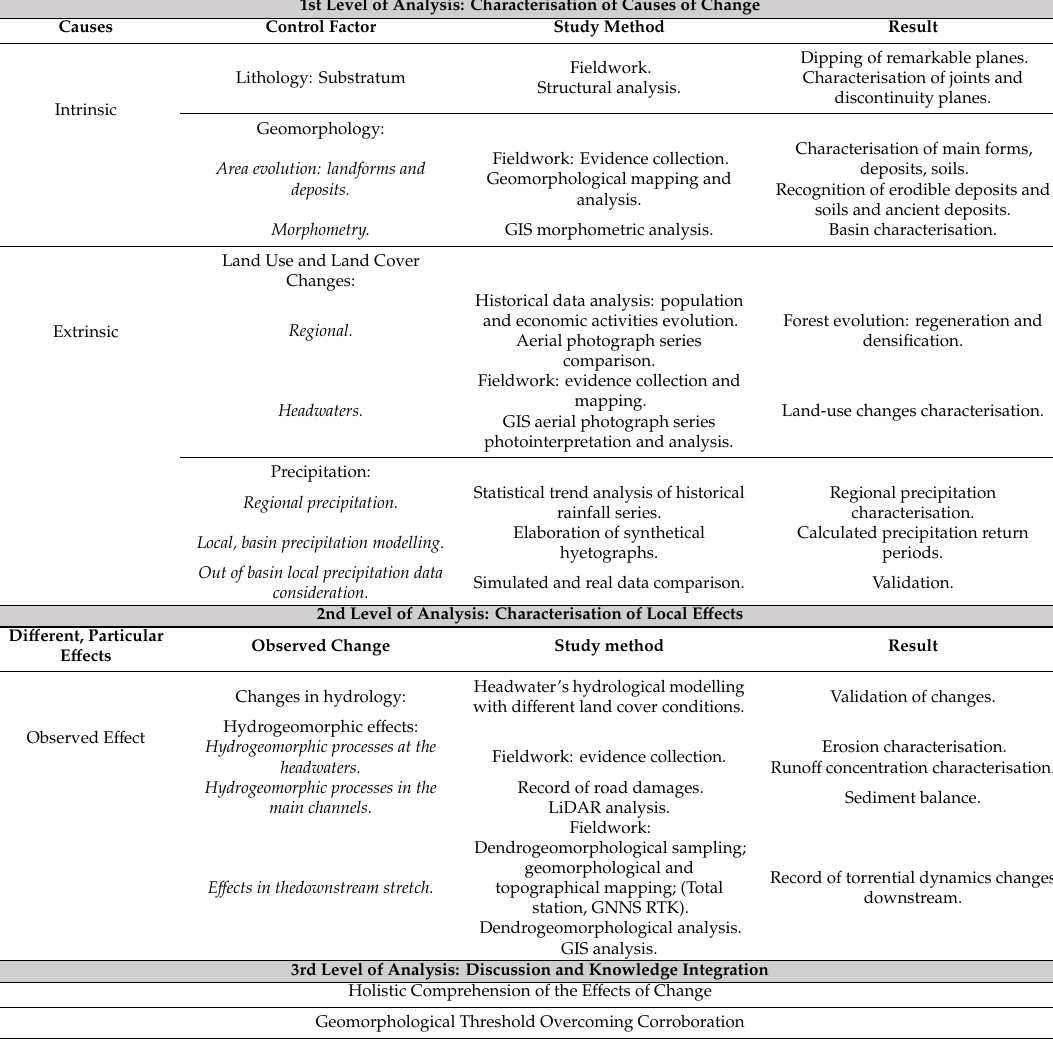
Table 3. Synthesis of the methodology used to carry out the present research, with 3 levels of analysis and considering causal control factors, local e ff ects and global consequences in the studied